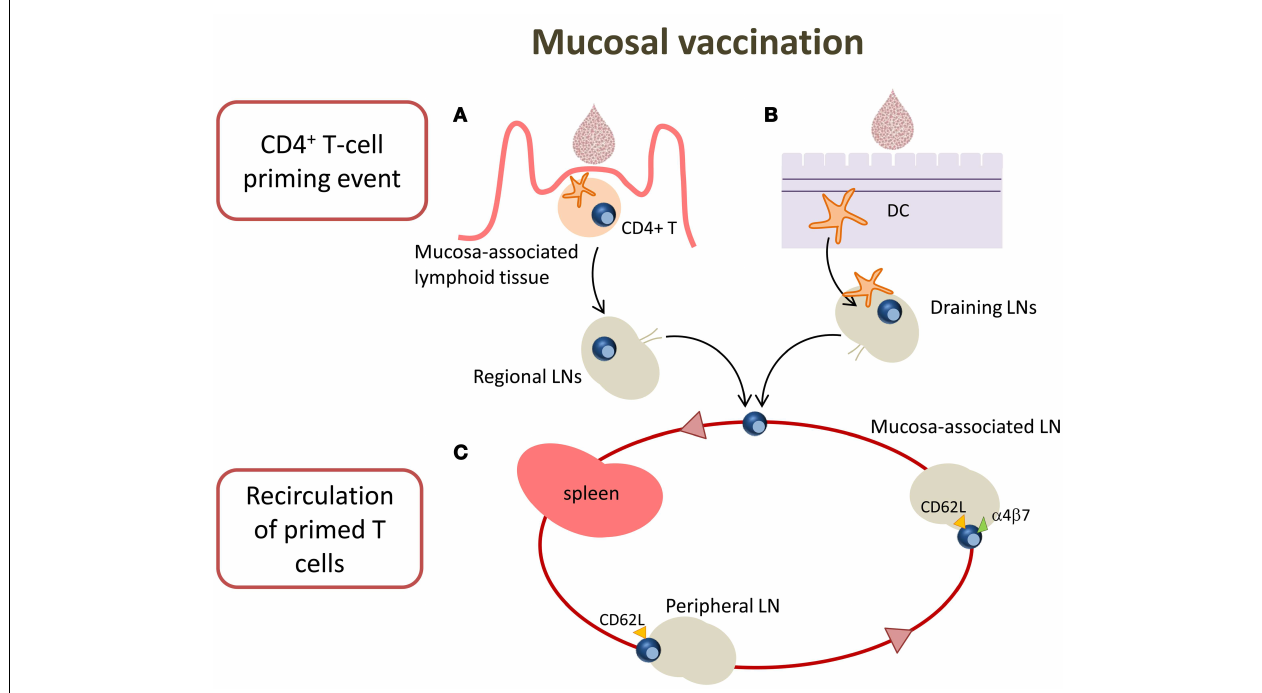
devoid of histologically demonstrable organized mucosa-associated lymphoid tissue, therefore after immunization, the antigen is sampled by tissue-resident DCs and transported into the draining iliac LNs that constitute the inductive site. PrimedT cells exit the LNs and migrate through the lymphatic system into the blood. (C) A fraction of mucosally primedT cells transiently circulates through the blood into the spleen and disseminates into non-draining LNs; the entry into peripheral LNs is CD62L-dependent, while into mesenteric LNs depends on both CD62L and α 4 β 7